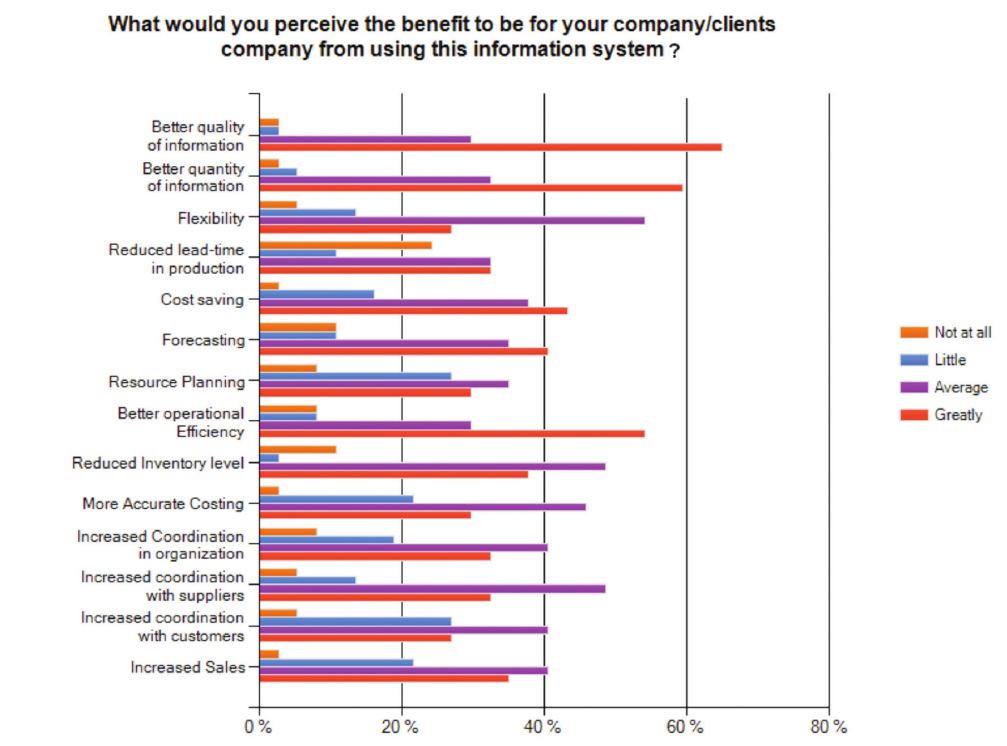
Figure 6: Perceived benefits from adopting AIS in the supply chain